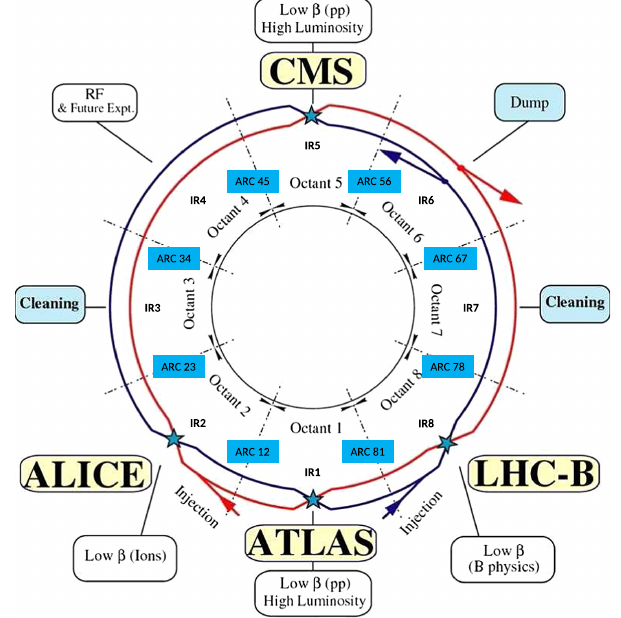
FIG. 1. LHC schematic configuration showing clockwise beam 1 colliding with counterclockwise beam 2 in the four different experiments